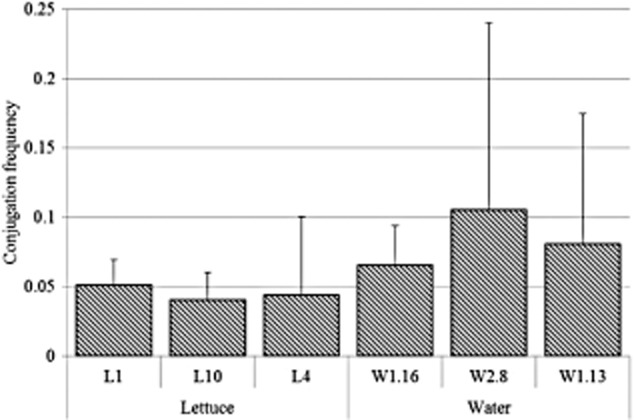
The frequency of conjugative ESBL/AmpC β-lactamase resistance gene transfer among E. coli from lettuce and irrigation water. Vertical bars represent standard deviations.